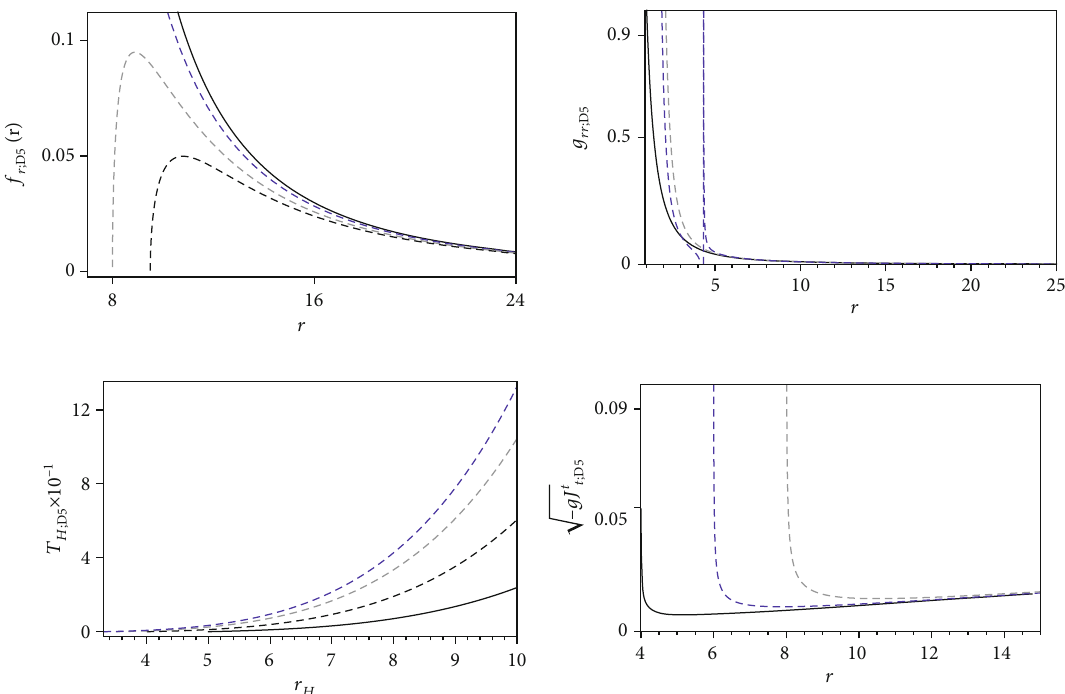
= 7 , ω = 0 (black-solid), ω = 5 0 component of the D5-brane rr = 1 : 5 , ω = 7 : 5 (blue-dashed). 0 = 5 (black-solid), r = 4 (black- 0 0